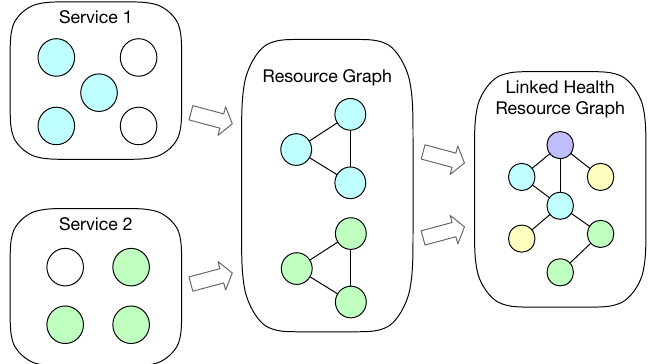
Figure 1. A simple overview of the integration process (each circle stands for a resource). Resources are aggregated from services into semantic resource graphs, which are then integrated as a Linked Health Resource